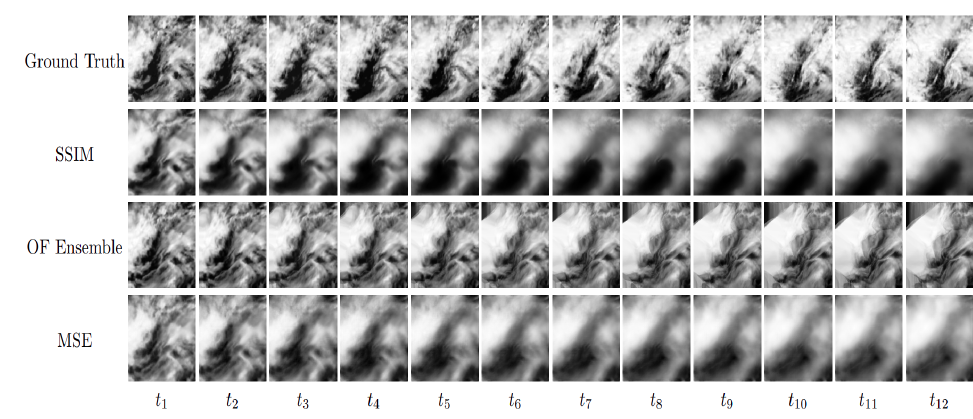
Figure A5. Example 3 h nowcasts over Italy on 31 March 2018.